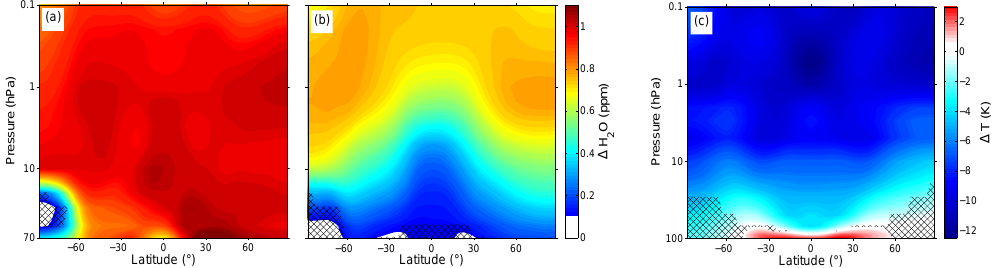
Figure 5. Impact of changes in climate and methane on SWV: (a) Increase in water vapour between the 1960s and 2090s in the RCP 6.0-fEmis-fCH 4 simulation (2090s minus 1960s); (b) increase in water vapour in the 2090s decade between the RCP 6.0-fEmis and RCP 6.0-fEmis-fCH 4 simulations (RCP 6.0-fEmis minus RCP 6.0-fEmis-fCH 4 ); and (c) zonal-mean temperature change in the RCP 6.0-fEmis- fCH 4 simulation (2090s minus 1960s). Hatching shows where the difference is not statistically significant at the 95% level of confidence, calculated with Student’s t